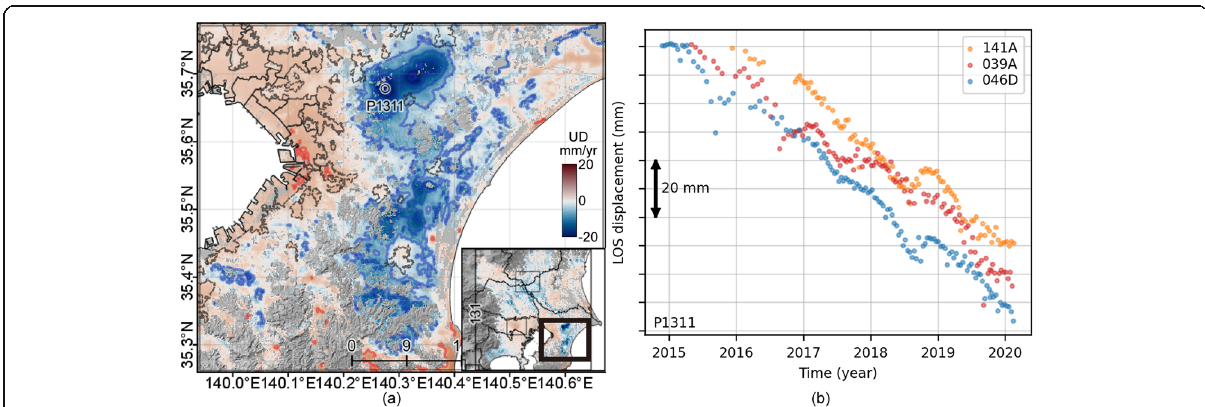
Fig. 3 a Vertical deformation velocities in Kujyukuri (ID: 131, Kanto). The black lines denote the outlines of the DID. The interval of the red (uplift) and blue (subsidence) contour lines is 5 mm/year without the 0 mm/year lines. The inset denotes the whole area of the 131 Kanto. b LOS deformation time series at P1311 for each frame